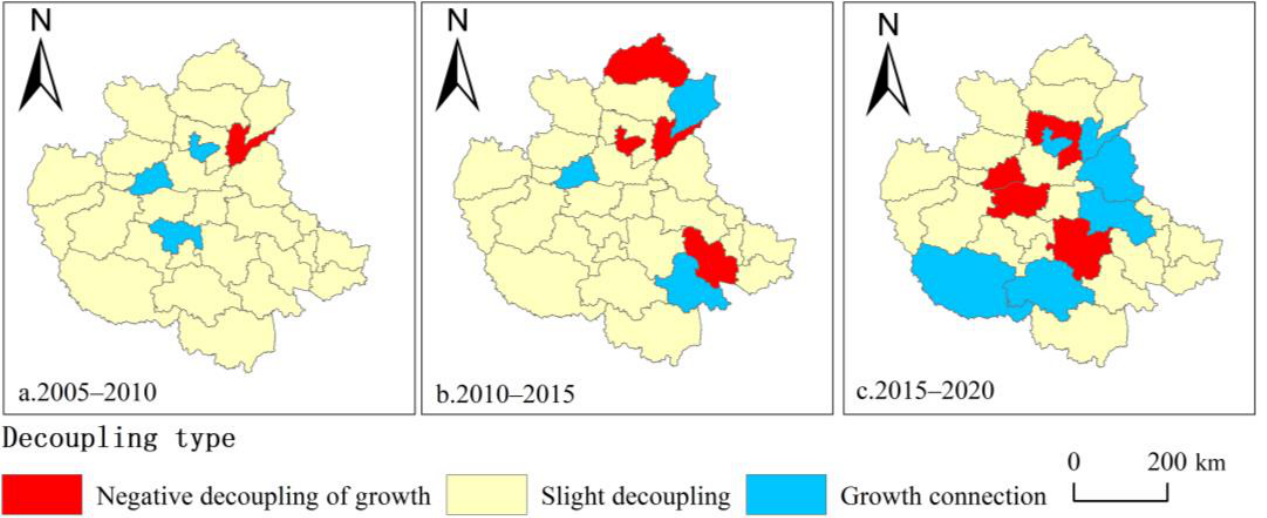
Figure 8. Types of decoupling between urban expansion and economic growth. ( a ) 2005–2010 De-